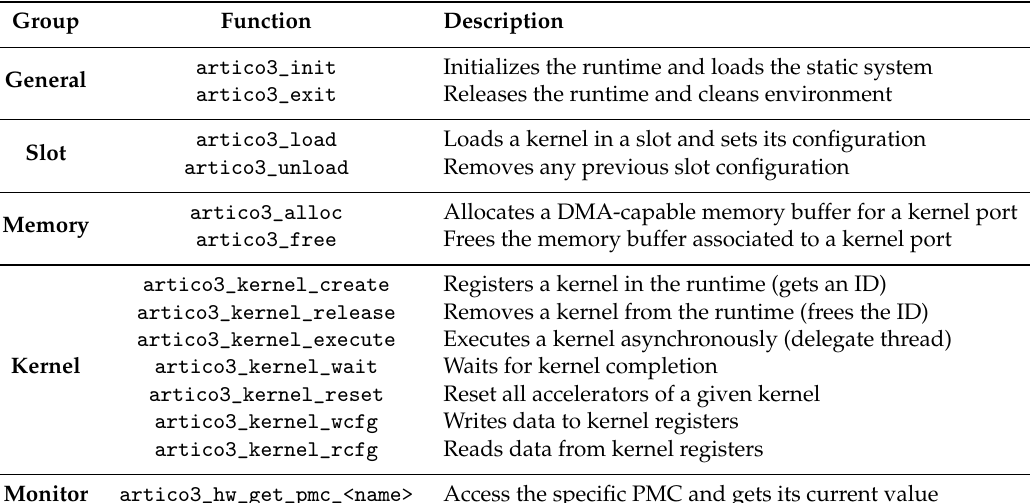
Table 2. ARTICo 3 Runtime